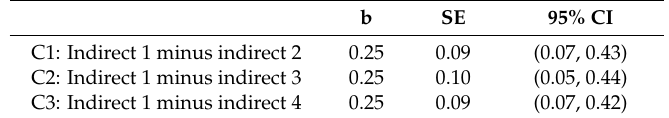
Table 4. Contrasting indirect effects between health planning and health behavior.